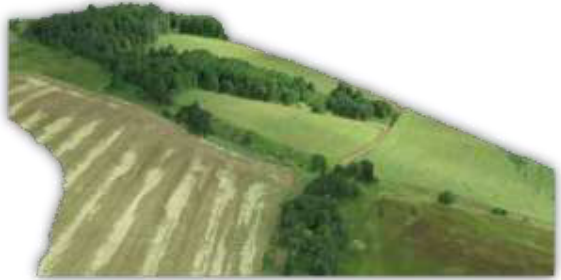
Figure 5. Digital surface model generated from UAV